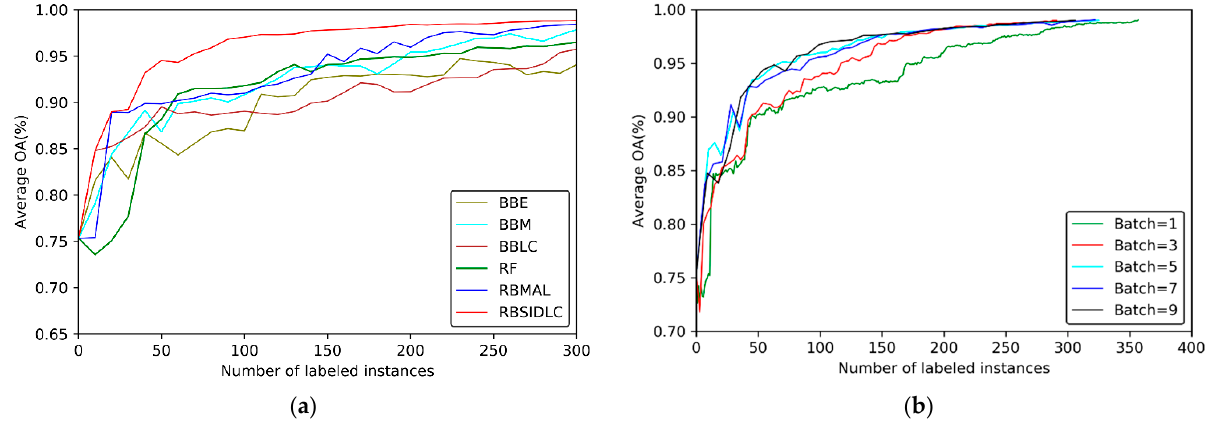
Figure 10. Iterative querying of preferred features: ( a ) training accuracy; ( b ) effects of the batch size in the proposed AL algorithm on preferred feature results.